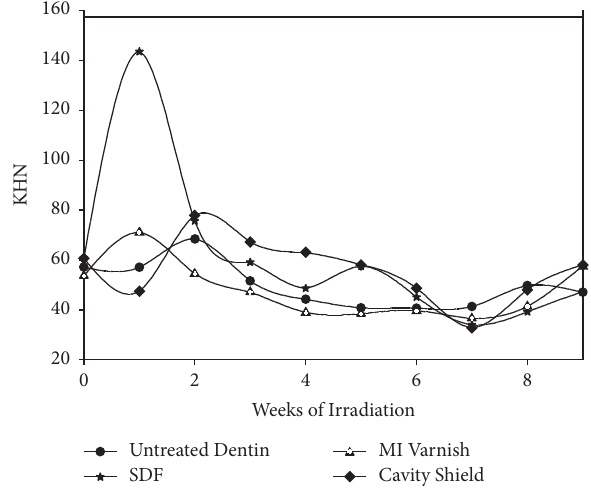
Figure 1: Dose/time dependence of KHN on